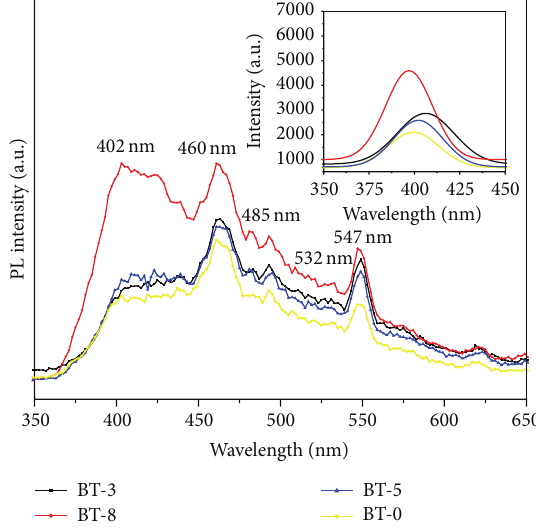
Figure 3: Photoluminescence spectra of undoped and doped −1 ), in rutile